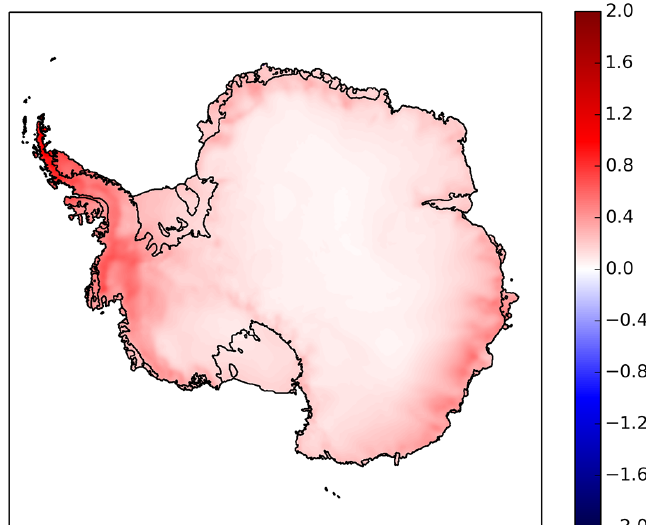
Figure A2. Surface mass balance interpolated from observations (myr − 1 ) around Antarctica (Arthern et al., 2006).